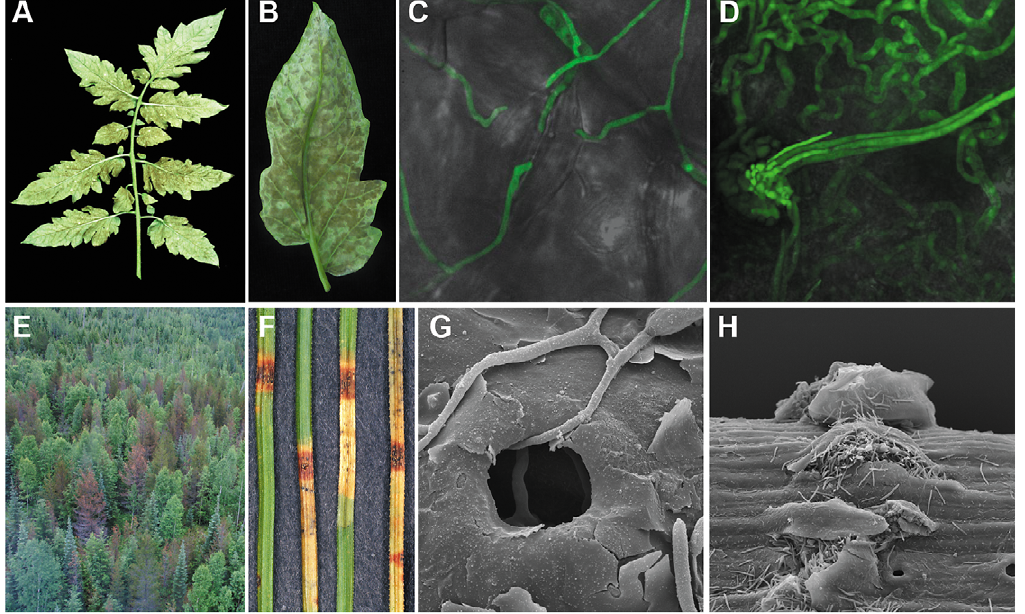
Figure 1. Symptoms caused by Cladosporiumfulvum and Dothistromaseptosporum on their host plants. (A–D) Disease symptoms of Cladosporium fulvum on tomato. A) C. fulvum sporulating on the lower side of a tomato ( Solanum lycopersicum ) leaf two weeks post inoculation; B) Close-up of C. fulvum sporulating on the lower side of a single leaflet two weeks post inoculation; C) Runner hyphae of C. fulvum (GFP-transgenic strain) at the surface of the leaf; two of them are penetrating a stoma of tomato four days post inoculation; D) Conidiophores of C. fulvum (GFP- transgenic strain) emerging from a stoma at 10 days post inoculation. (E–H) Disease symptoms of Dothistroma septosporum on pine. E) Mortality of mature lodgepole pines ( Pinus contorta var. latifolia ) in northwest British Columbia, Canada caused by D. septosporum ; F) Red band lesions with conidiomata on Pinus radiata needles; G) Penetration of hypha into stoma of P. radiata needle 4 weeks post inoculation; H) Eruption of conidiospores through epidermis of pine needle 8 weeks post